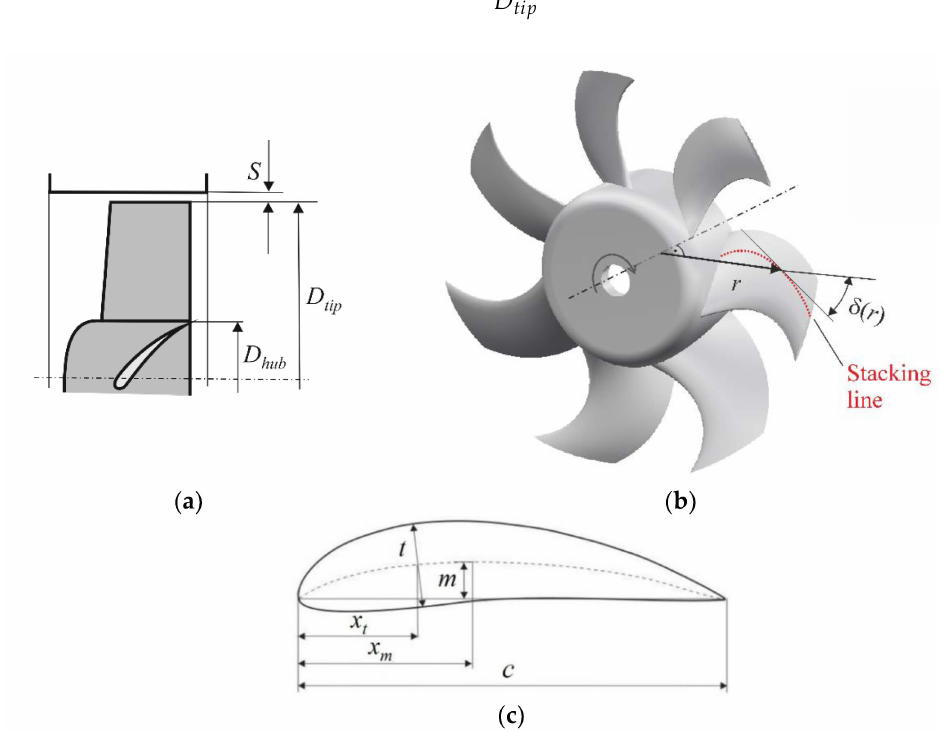
Figure 3. Illustration of geometrical parameters: ( a ) impeller with part of the duct-type casing; ( b ) definition of the sweep angle; ( c ) 4-digit NACA